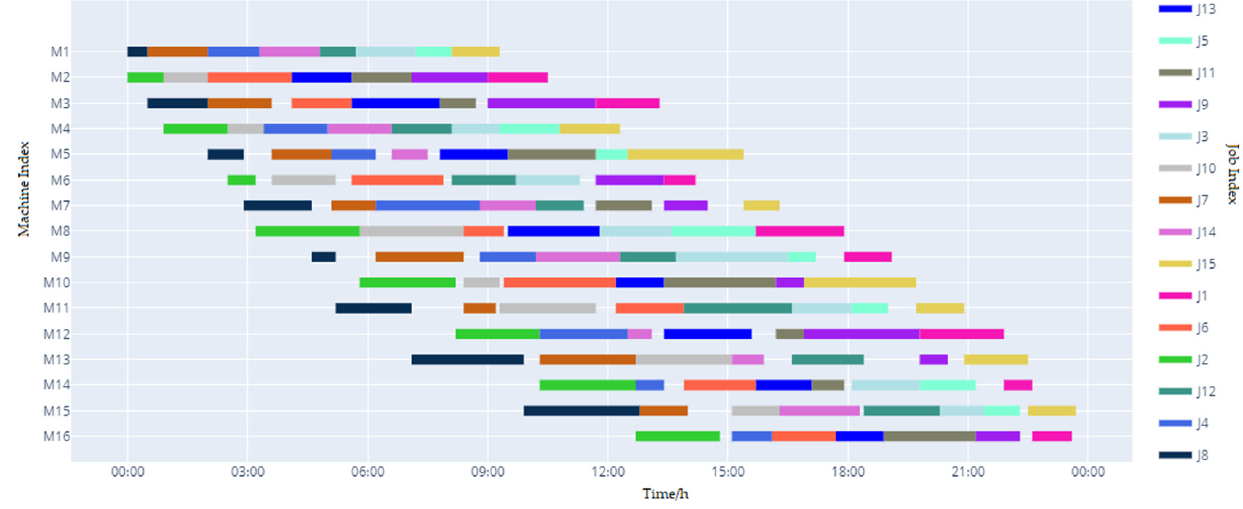
Figure 7. Gantt before Right-Shift.